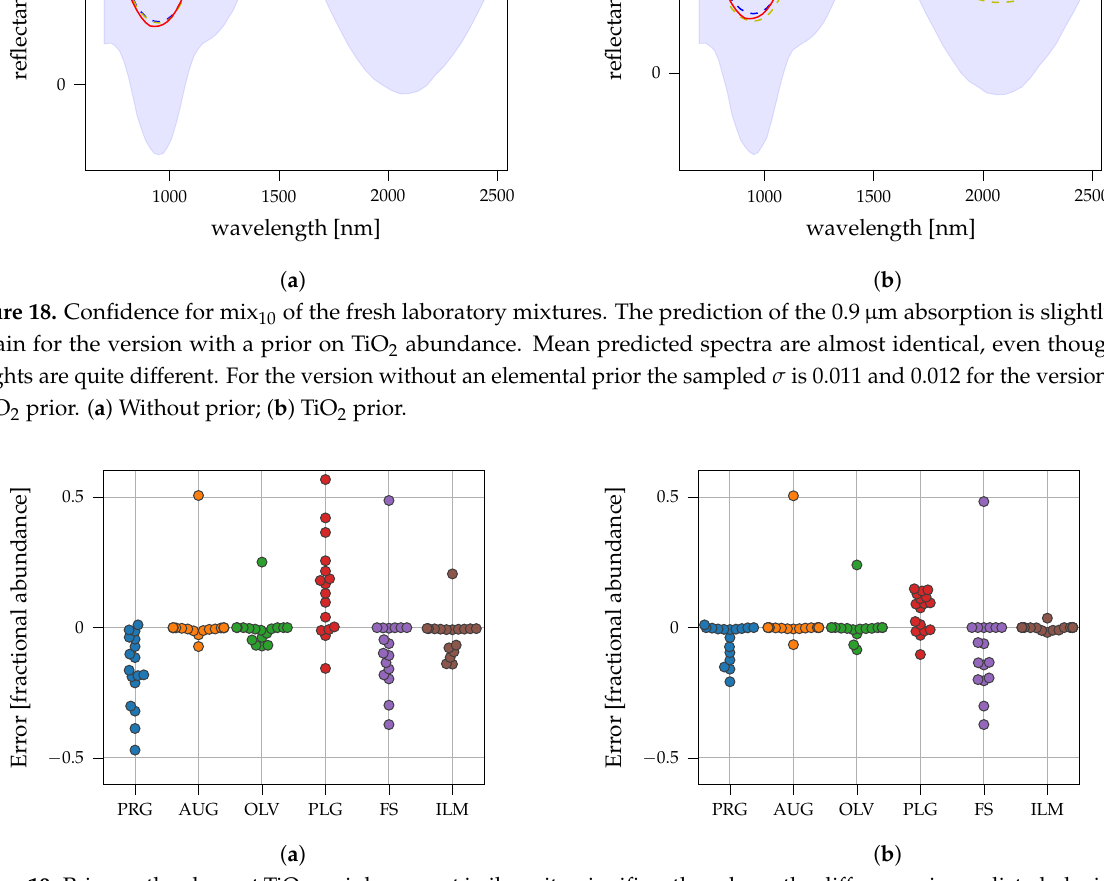
Figure 19. Prior on the element TiO 2 mainly present in ilmenite, significantly reduces the differences in predicted plagioclase and also pargasite abundance and theoretical abundances. These spectra of the three endmembers are relatively flat and do not show significant absorption bands. ( a ) Without prior; ( b ) TiO 2 prior.